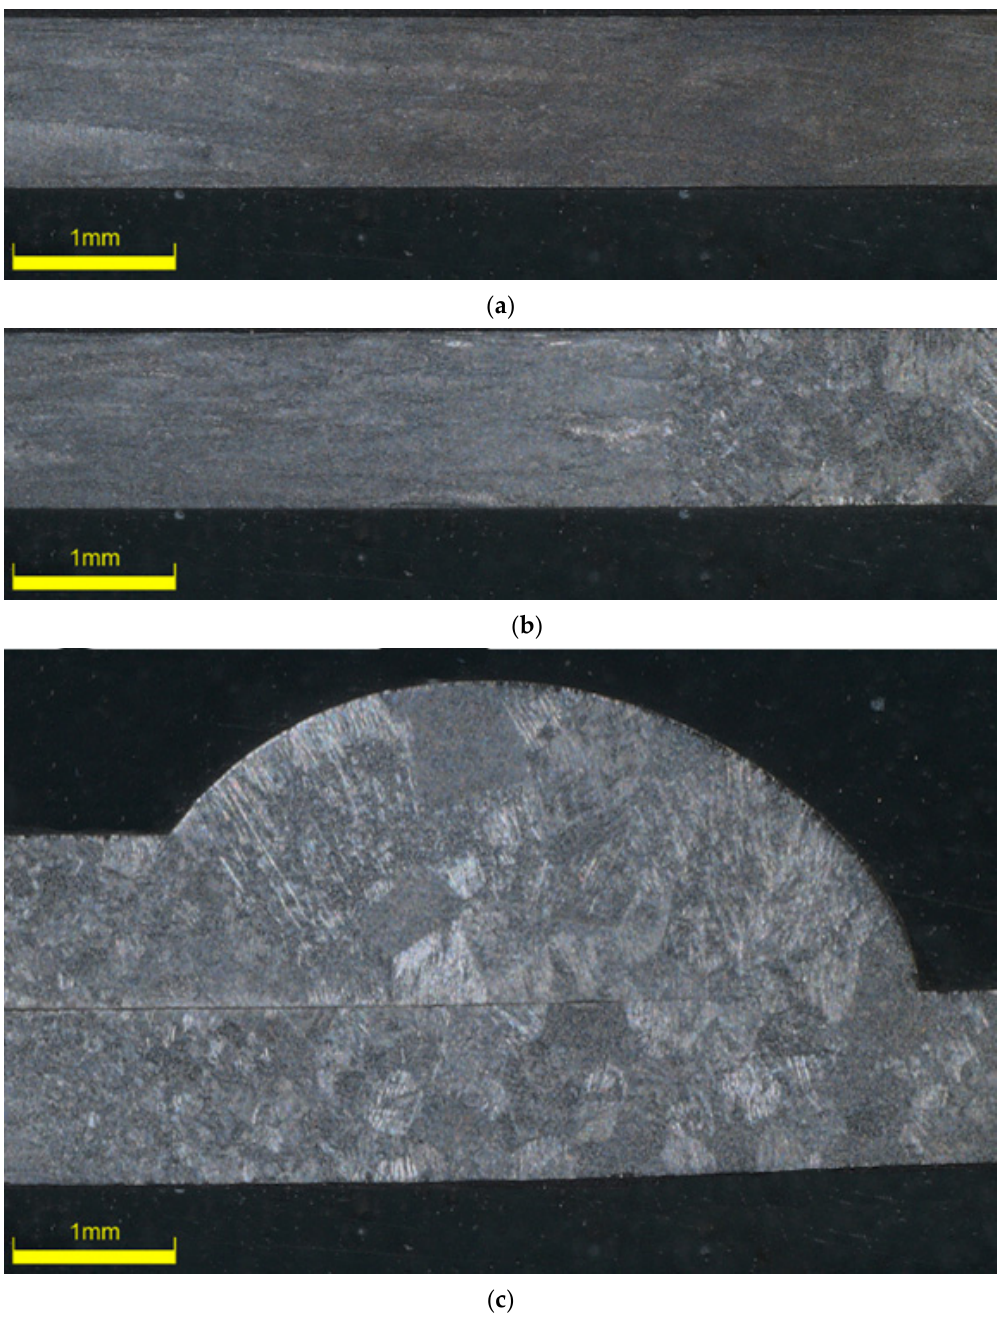
Figure 16. Microstructure of titanium sheet ( a ) and Type 2 ( b ) and Type 3 ( c ) welded samples obtained by microplasma welding at ×30 magnification.